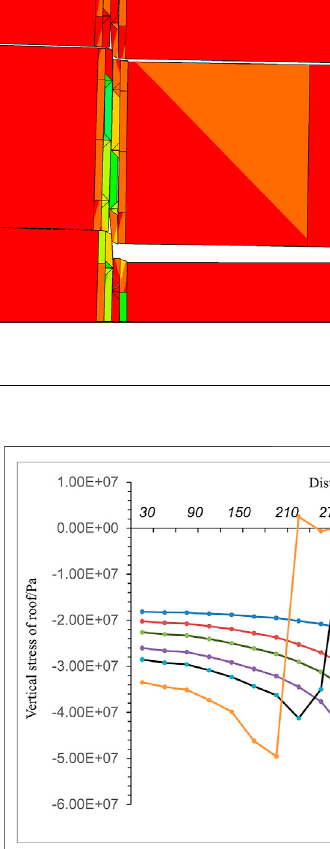
FIGURE 12 | Vertical stress at the top of blast hole.